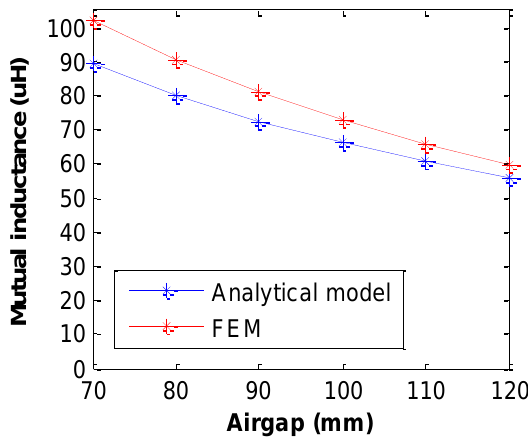
Figure 9. Impact of air-gap on the 3.7 kW system.